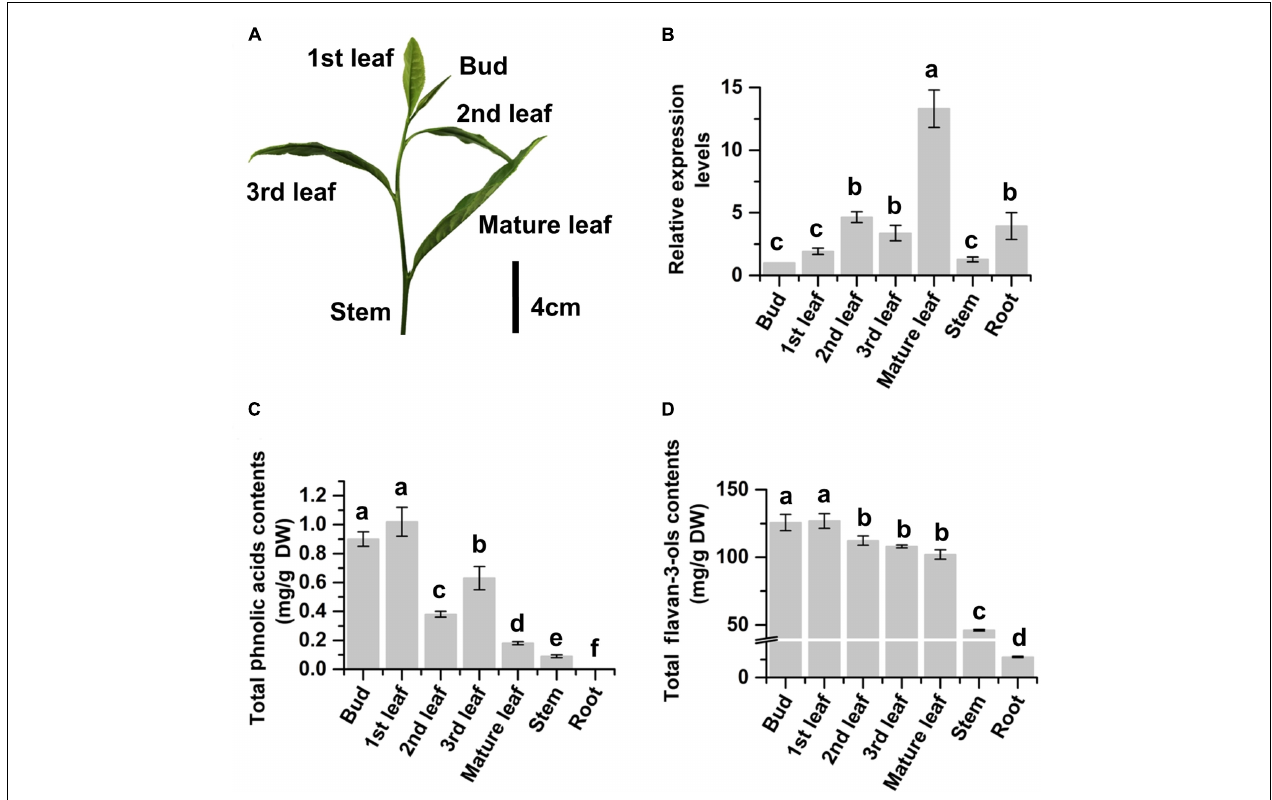
FIGURE 2 | Relative expression levels of CsMYB4a and contents of phenylpropanoid metabolites in different organs of tea plants. (A) A picture shows a bud and different developmental stages of leaves (1st, 2nd, 3rd, and mature) collected from multiple plants for gene expression and phenylpropanoid metabolite analyses. (B) qRT-PCR data show expression profiles of CsMYB4a in buds, leaves (different stages), young stems, and roots. (C) Total phenolic acid’s contents summed from the contents of both caffeoylquinic acid and p-coumaroylquinic acid in buds, leaves (different stages), young stems, and roots. (D) Total flavan-3-ols contents in buds, leaves (different stages), young stems, and roots. Values represent the mean ± SD ( n = 3). The lowercase “a, b, c, d” labeled on top of bars indicate that those values are significantly different from that of the equivalent control in B–D